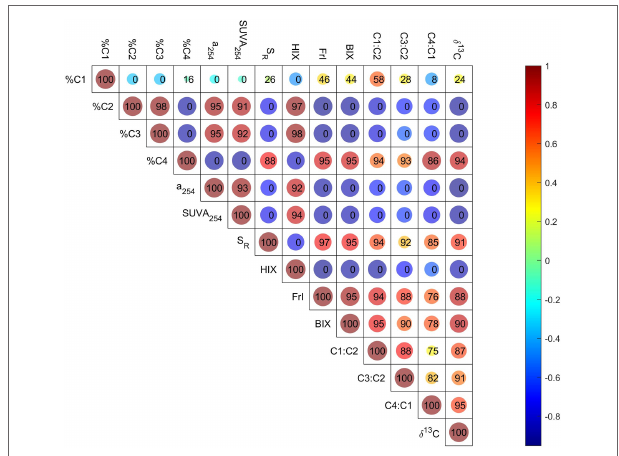
FIGURE 5 | Correlations (Pearson) among isotopic parameters and optical indices, and the similarities of their positively correlated (Spearman) formulas. The size and color of the circle are related to the correlation coefficient. The number in the circle indicates the similarity of correlated molecular formulas associated with the corresponding two parameters; 100 means the formulas associated with these two parameters are the same, and 0 means there is no common